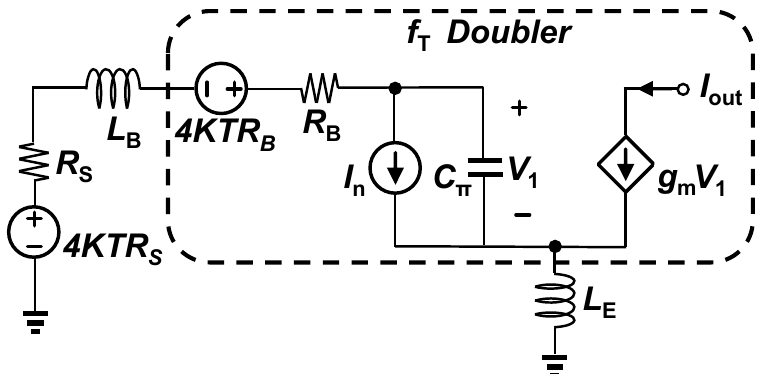
Figure 3. Simplified small-signal noise model of the proposed TSV-integrated f T -doubler amplifier.